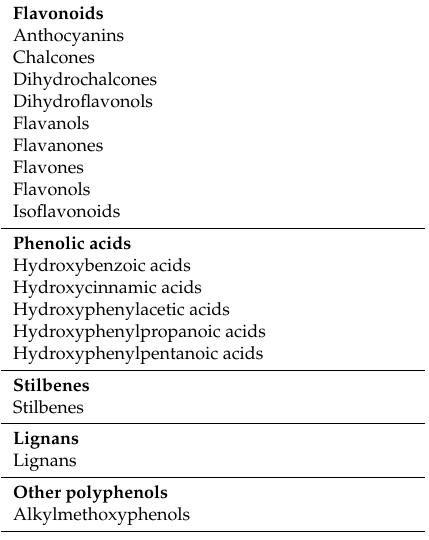
s1, Figure S1: Sleep duration assessment method, Figure S2: The relationship between fruit and vegetable intakes and sleep duration using locally weighted scatterplot smoothing (LOWESS), Figure S3: Normal distribution of sleep duration (outcome) using histogram plot.